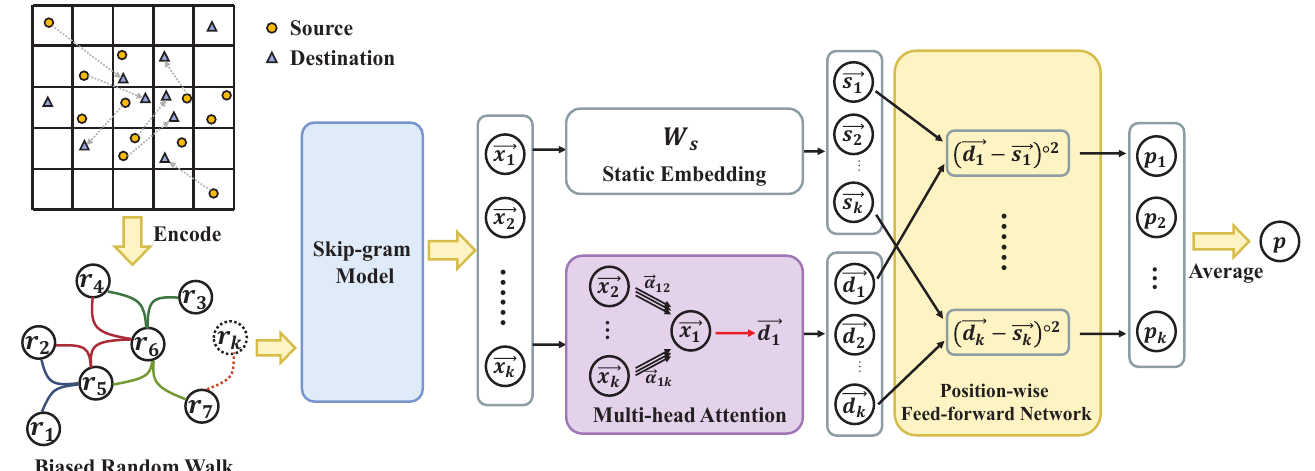
Figure 2. The structure of the shareability prediction model based on Hyper-SAGNN